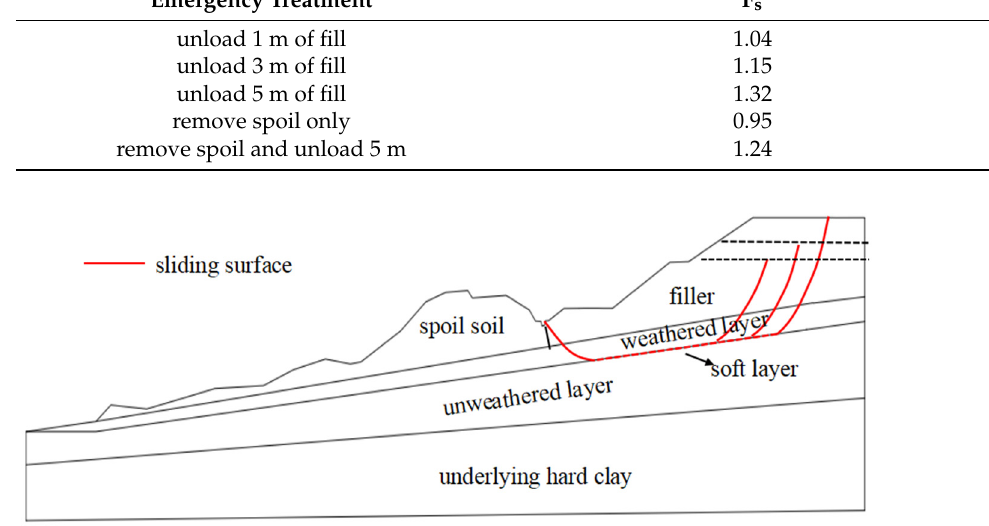
Figure 13. Influence of different unloading heights on slope sliding surface.